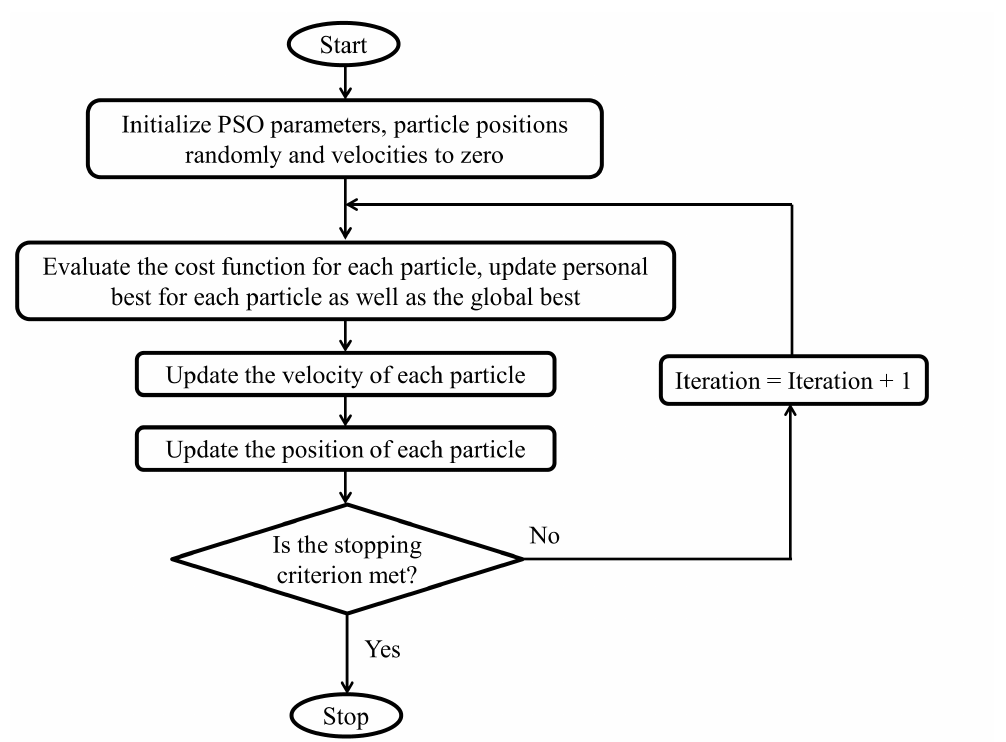
Figure 2. Flowchart of the PSO optimization